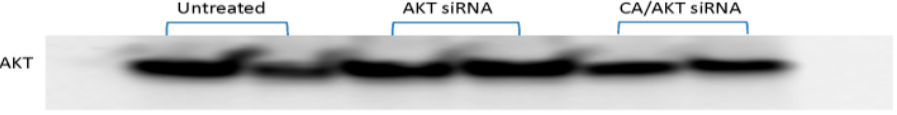
Figure 1. AKT protein expression in MCF-7 cells. Cells were treated with media (untreated), free AKT siRNA, and CA / AKT siRNA formed with 3 mM of CaCl 2 and 1 nM siRNA for 44 h. Cellular lysates were resolved by SDS-PAGE and transferred in PVDF membrane followed by incubation with primary antibodies raised in rabbit against AKT. HRP-conjugated goat anti-rabbit secondary antibody was used to detect the chemiluminescent signals.